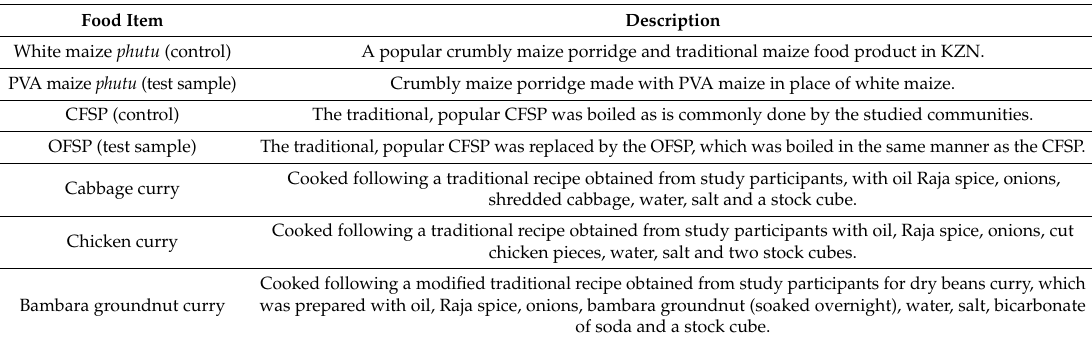
Table 1. Methods of food items used in the